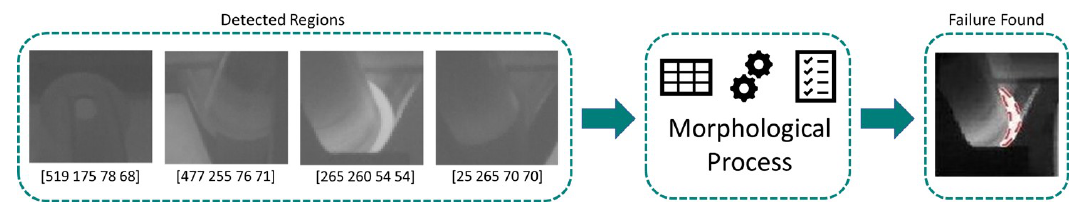
Figure 8. Assessment of defects on rollers.